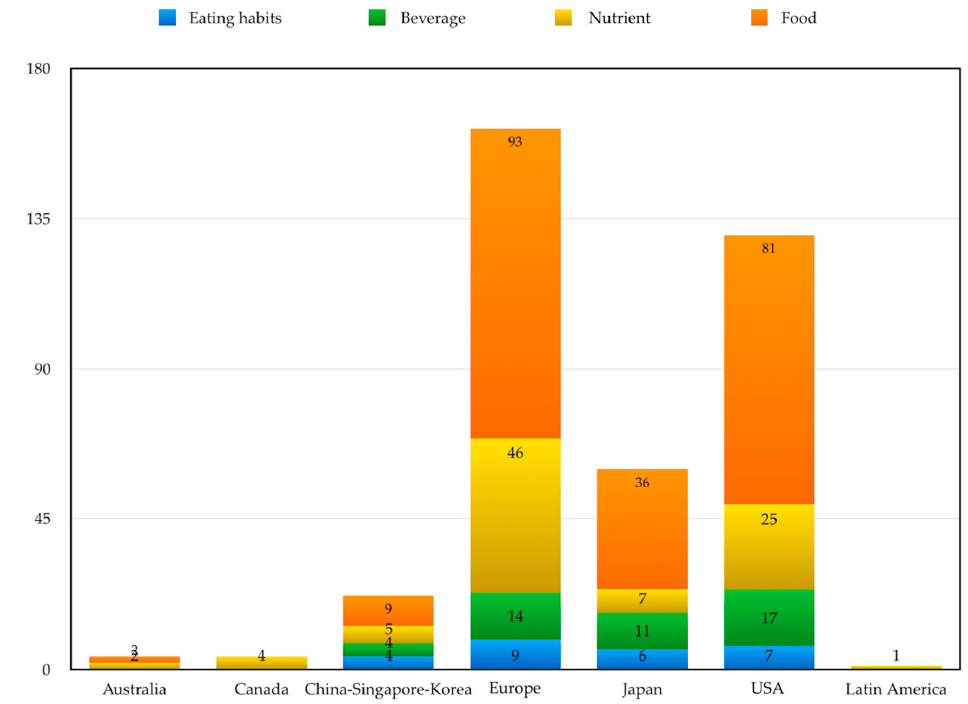
Figure 2. Distribution of primary studies included in meta-analyses considered according to geographic area and type of nutritional support.